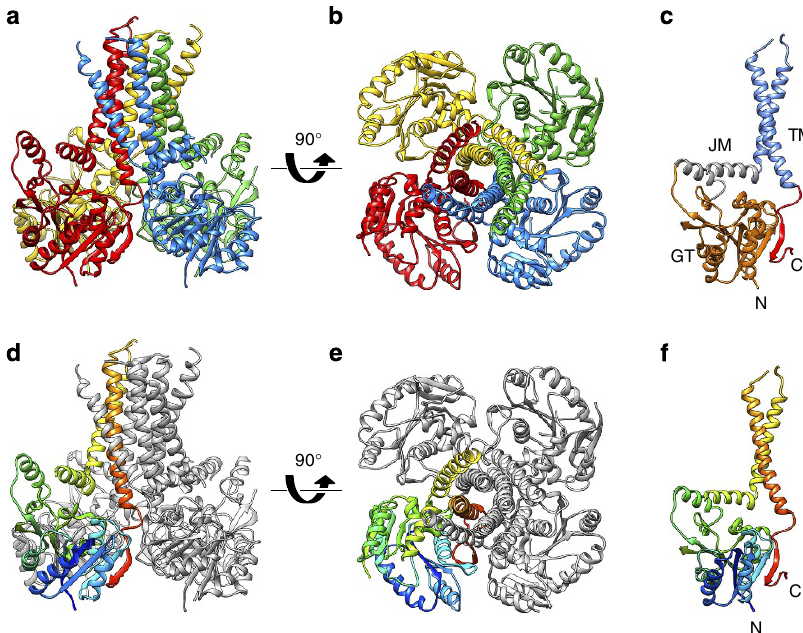
Figure 2 | Architecture of GtrB, an integral membrane PI-GT. The tetrameric assembly of GtrB, in which each of the four polypeptide chains is represented as a ribbon drawn in a different colour, is shown here ( a ) from a position orthogonal to the TM helices and ( b ) looking down the fourfold symmetry axis of the tetramer from the extracellular side. ( c ) A single protomer is shown. The protomer is comprised of a GT-A fold GTdomain (orange), two amphipathic juxtamembrane helices (grey; juxtamembrane (JM)), two TM helices (blue) and a C-terminal b -hairpin (red). ( d , e ) The GtrB tetramer is shown in the same two views and orientations as in a , b , with three subunits represented in grey ribbons and the fourth in rainbow colouring from the N-terminus (blue) to the C-terminus (red). ( f ) The GtrB monomer shown in the same orientation as in c , represented in rainbow colouring from the N-terminus (N; blue) to the C-terminus (C;